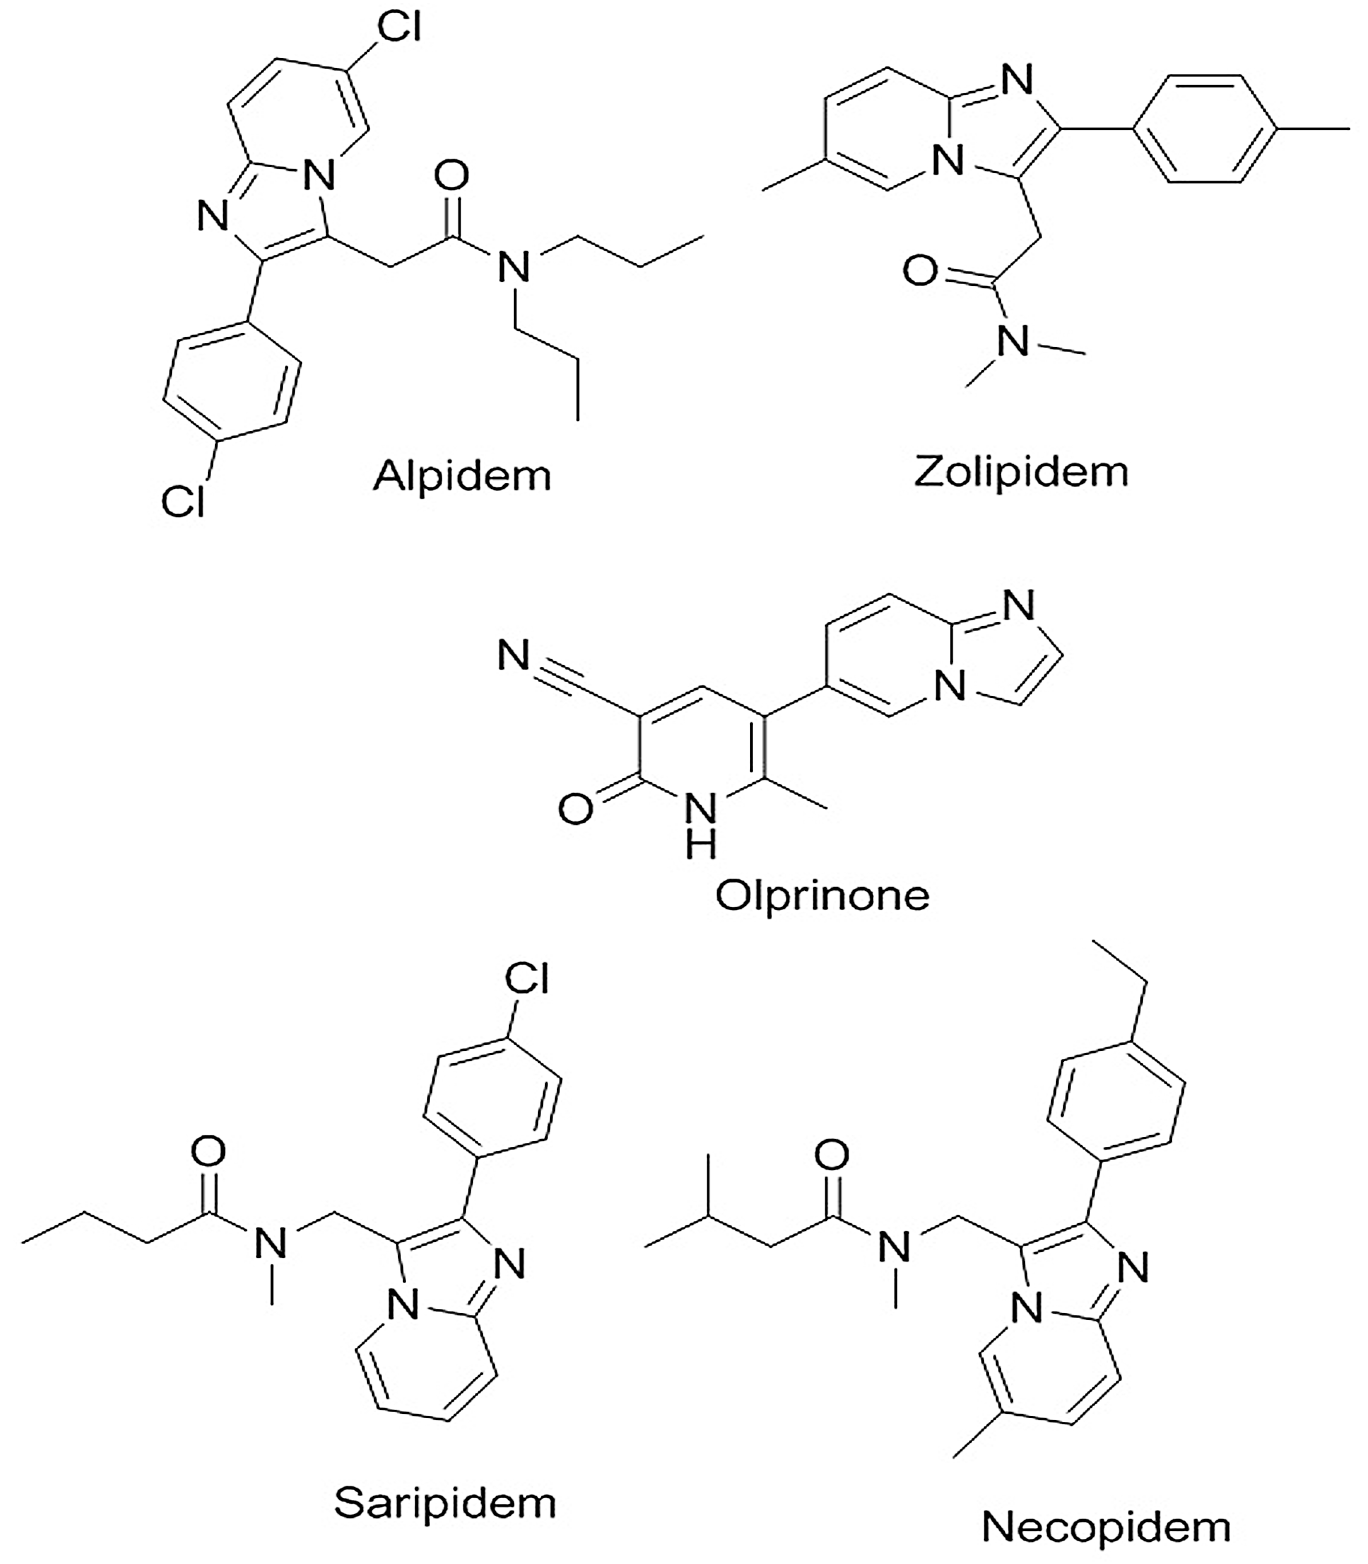
Fig 1. Structure of biologically active imidazo[1, 2- α ]pyridines. doi:10.1371/journal.pone.0131896.g001 PLOS ONE | DOI:10.1371/journal.pone.0131896 July 21,